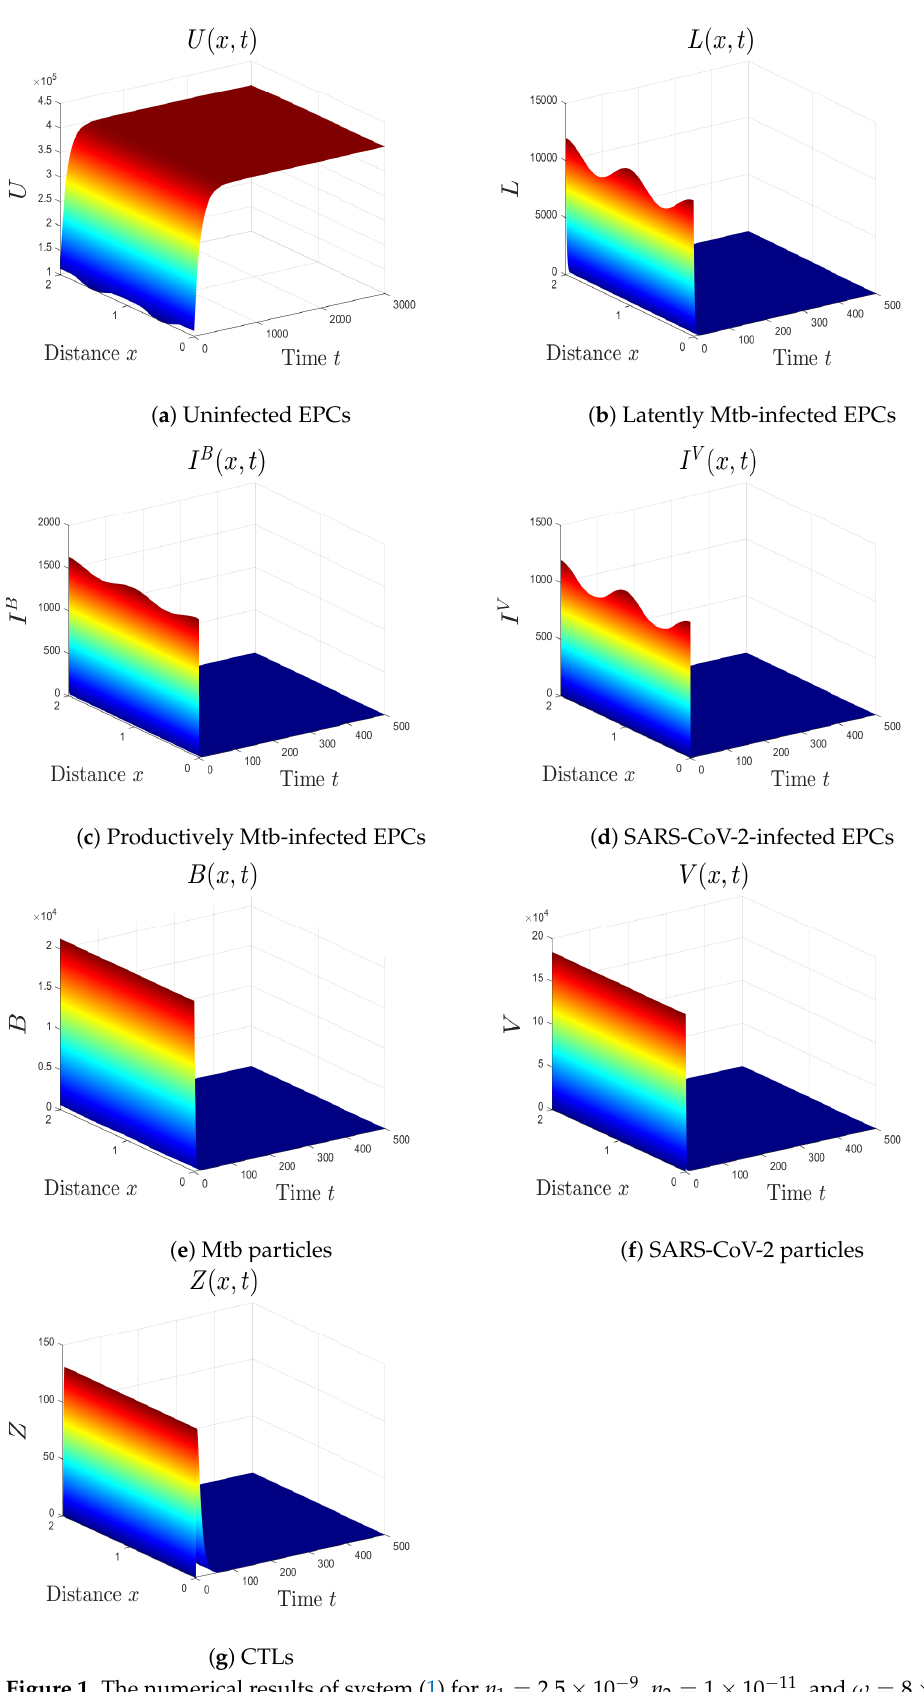
(cid:0) (cid:1) 4 × 10 5 ,0,0,0,0,0,0 is